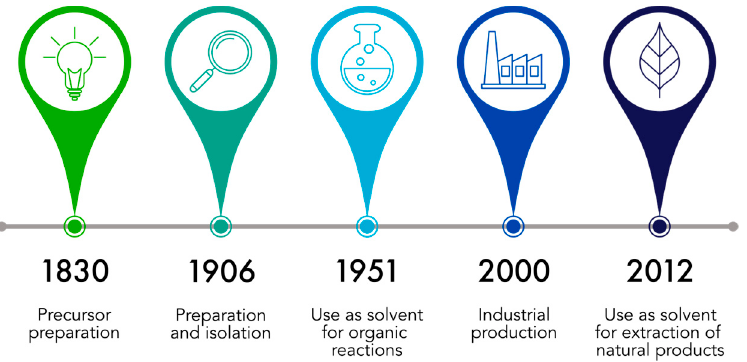
Figure 2. Chronological milestone of 2-MeOx production.